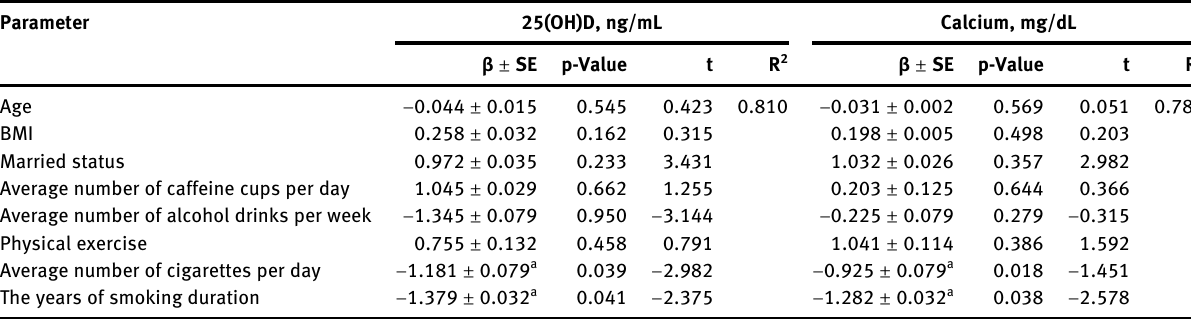
Table  : Multiple regression analysis between serum  (OH)D, calcium and the variables. Parameter